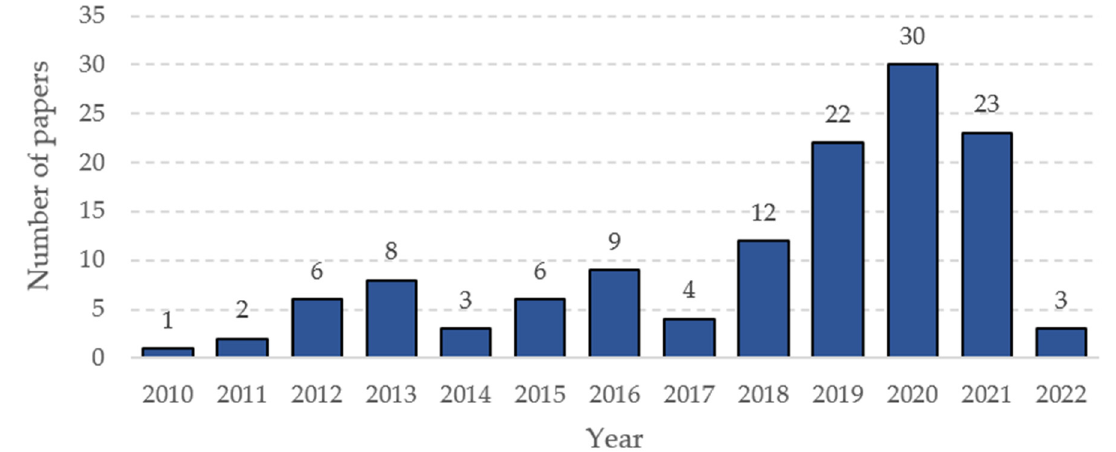
Figure 2. Number of articles by year of publication.